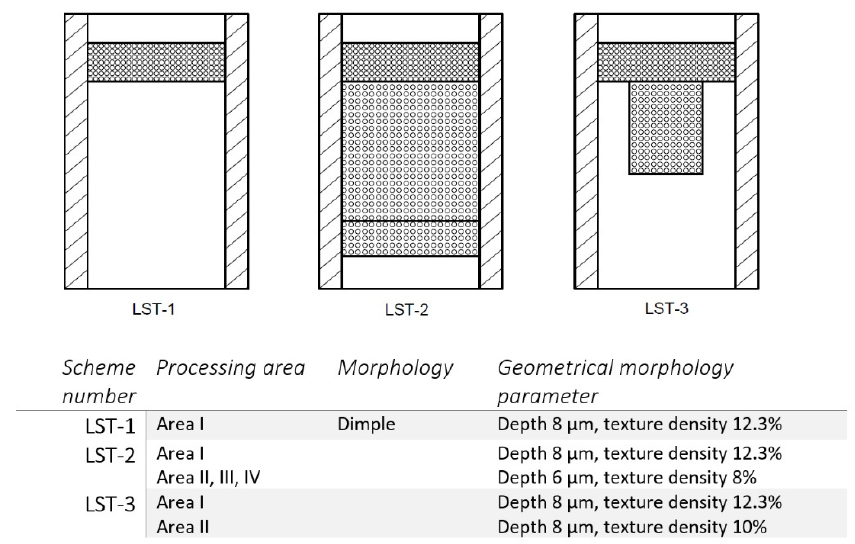
Figure 17. Oil pocket arrays on the surface of the cylinder liner, after [116].